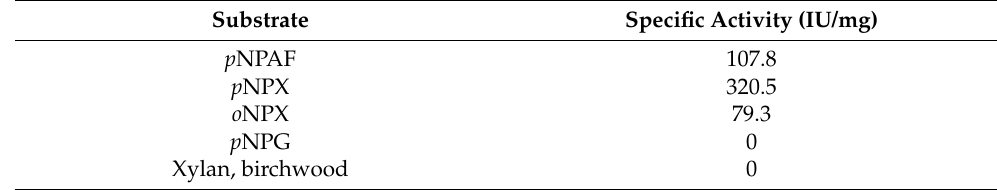
Table 1. Substrate specificity of the purified PpBXL.